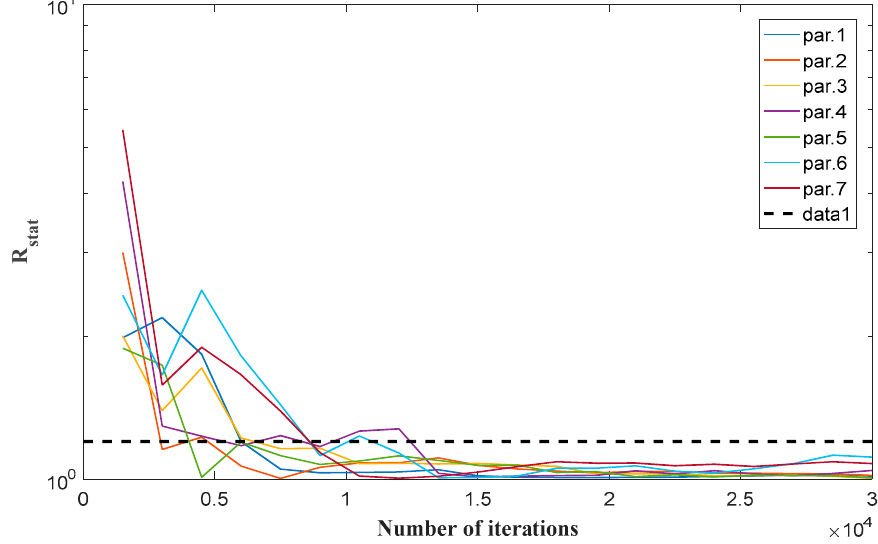
Figure 4. Convergence of the unsaturated soil parameters for linear transport: Variation of the Gelman – Rubin ( R stat ) with the number of iterations. The convergence is achieved if the chains reach the threshold in broken-line ( R stat ≤ 1.2).